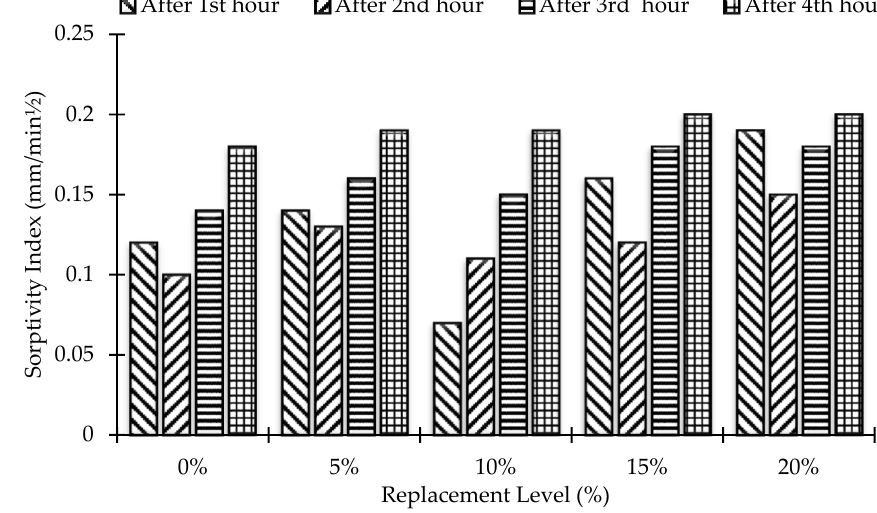
Figure 15. Replacement level versus percentage water absorption up to 4 h.